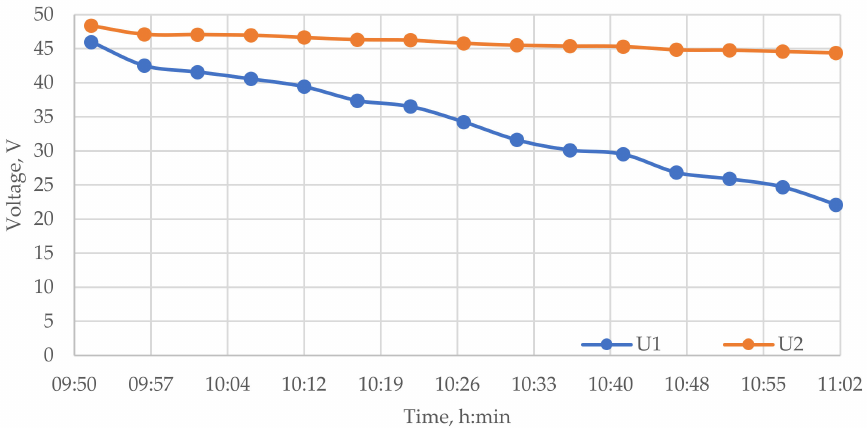
Figure 7. Discharged characteristics for stacks #1 and